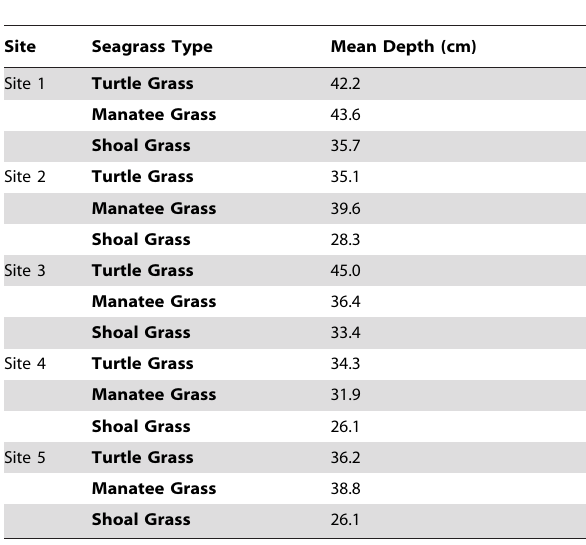
Table 1. Mean depth over sampling period in each seagrass patch at each site.